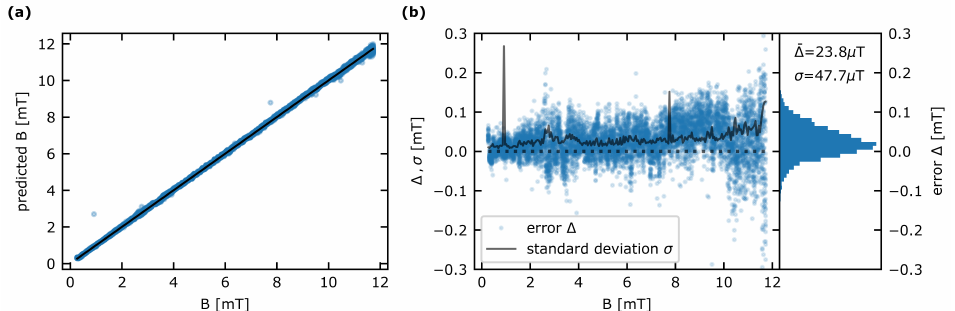
Figure 7. ( a ) Performance of the sensor device. In a total of 6250 measurements, the resulting RMS is 69.0 µ T. Single outliers can be attributed to random timing errors in the control sequence. ( b ) The error in the measurements ∆ = B predicted − B true is trending towards a larger spread for increasing magnitudes of magnetic field. Accordingly, the standard deviation of the error σ shows a shift towards higher values. Right: The distribution of the error ∆ for all 6250 measurements shows a mean value of ¯ ∆ = 23.8 µ T and a standard deviation of σ = 47.7 µ